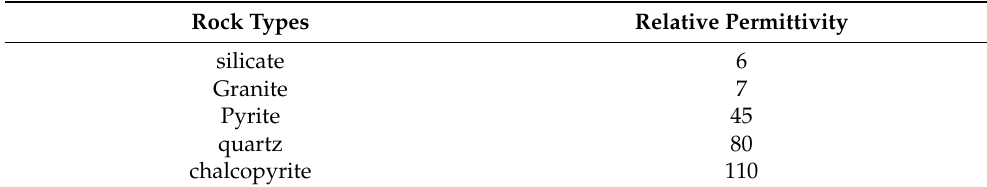
Figure 16. Variation of rock field strength with rock thickness.